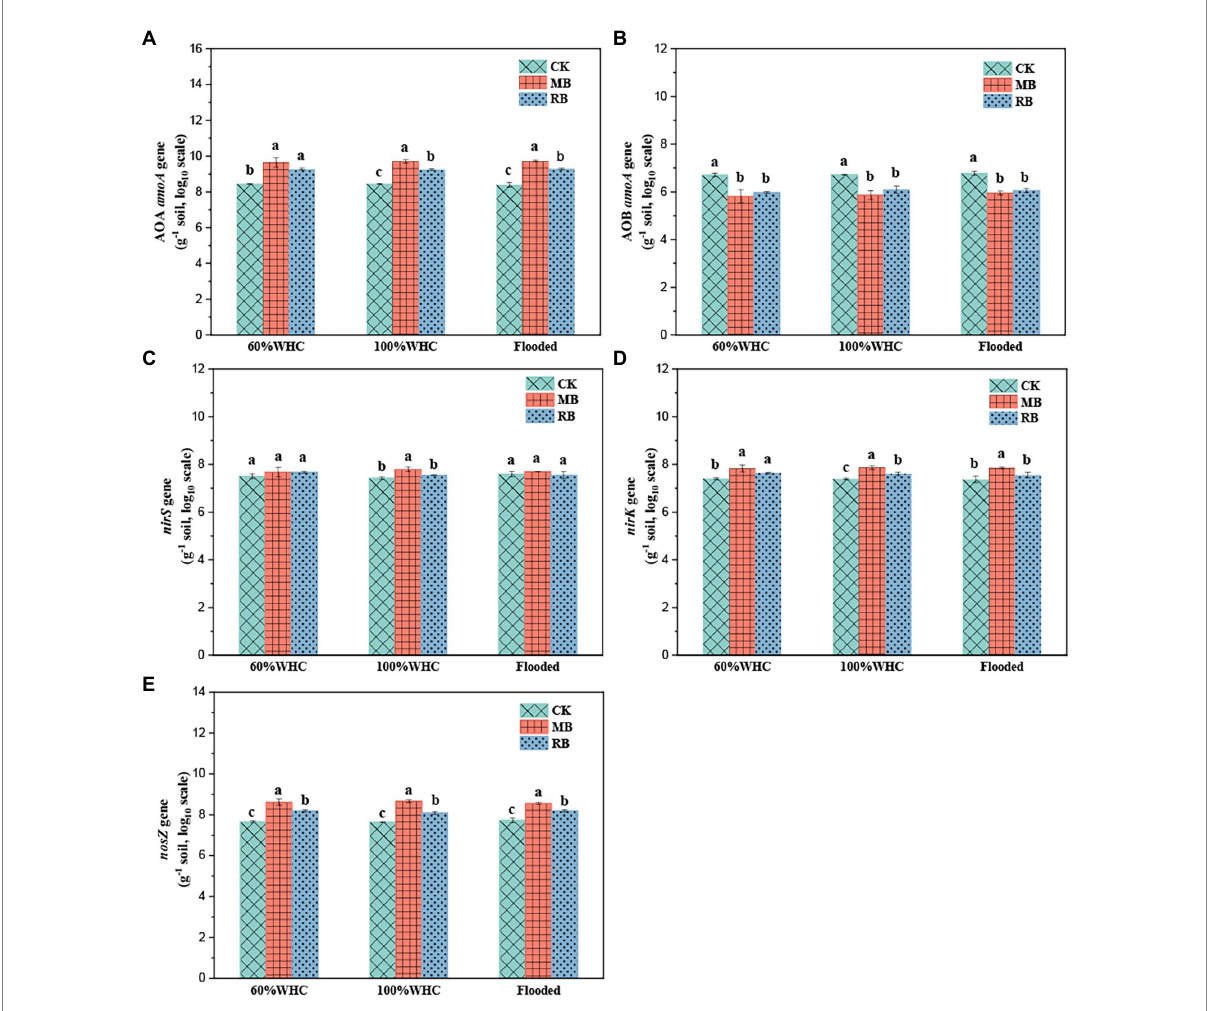
FIGURE 6 Abundance of the AOA amoA (A) , AOB amoA (B) , nirS (C) , nirK (D) , and nosZ (E) genes with biochar amendments on the first day after soil thawing (CK: control; MB: maize straw biochar; RB: rice straw biochar; a, b and c indicate significant differences among the different biochar treatments, p < 0.05; error bars represent the standard error, n =